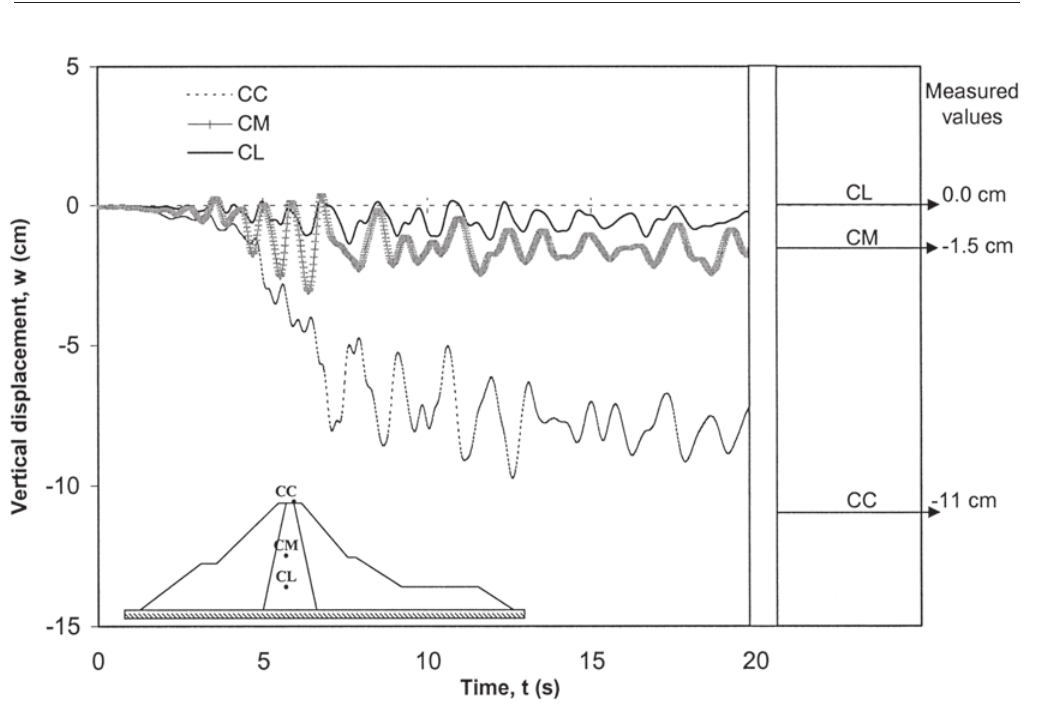
Fig. 12. Time histories of vertical displacement at three points along the dam